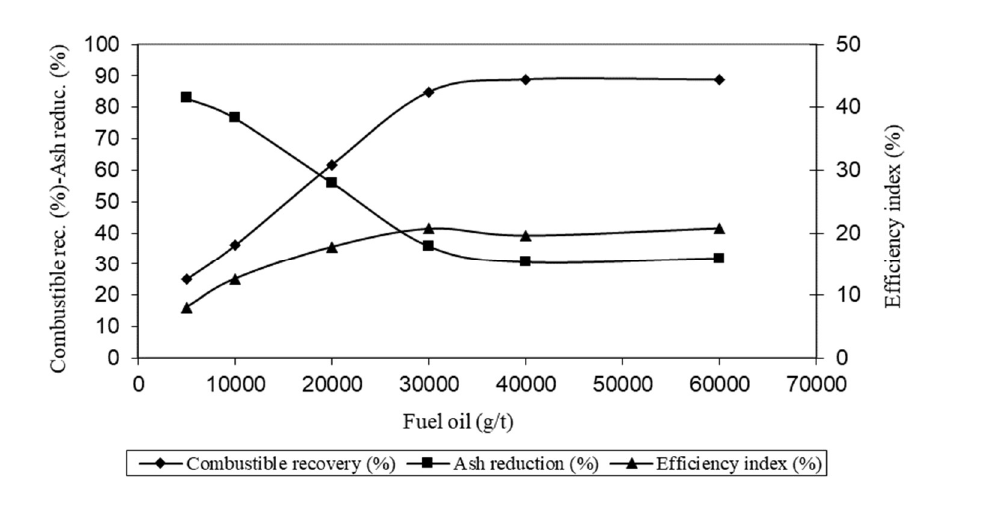
Fig.3 . The effect of fuel oil concentration on combustible recovery, ash reduction and efficiency